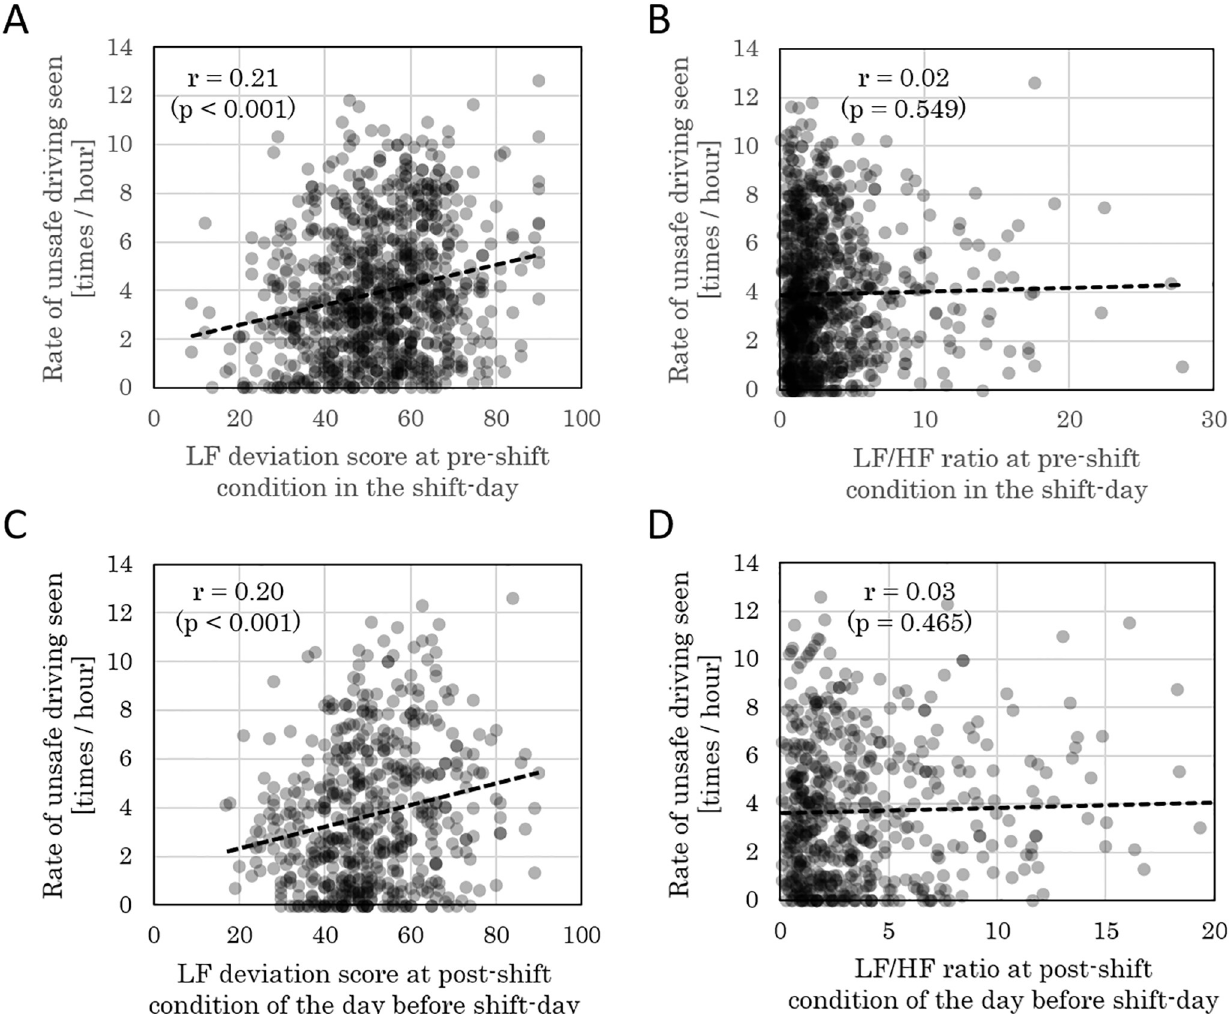
Fig 2. Relationship between collision risk and LF deviation score or LF/HF ratio. Correlation between the shift-day collision risk judgment frequency (daily collision risk index) R and (A) shift-day pre-shift LF deviation score, (B) LF/HF ratio. Correlation between R 1hr and (C) LF deviation score of post- 1hr shift condition for the day prior to shift-day, (D) LF/HF ratio. Pearson’s correlation coefficient and the p -value are as